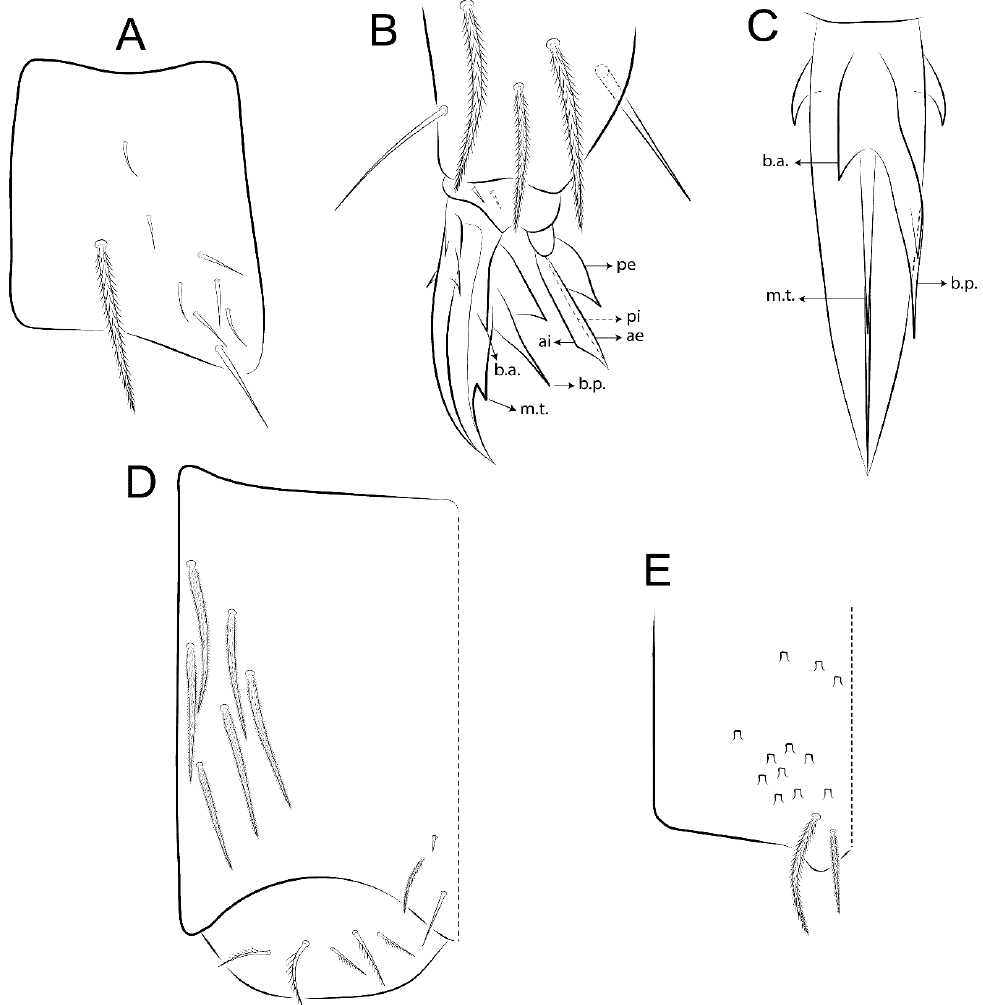
Figure 24. Pseudosinella labruspinata sp. nov.: trunk appendages. ( A ) trochanteral organ; ( B ) distal tibiotarsus and empodial complex III (anterior view); ( C ) unguis (inner view); ( D ) collophore (lateral view); ( E ) distal part of manubrium (ventral view).